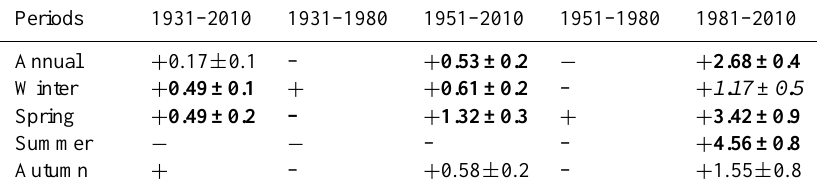
Table 5. As Table 1, But For Estimated Clear-sky SSR